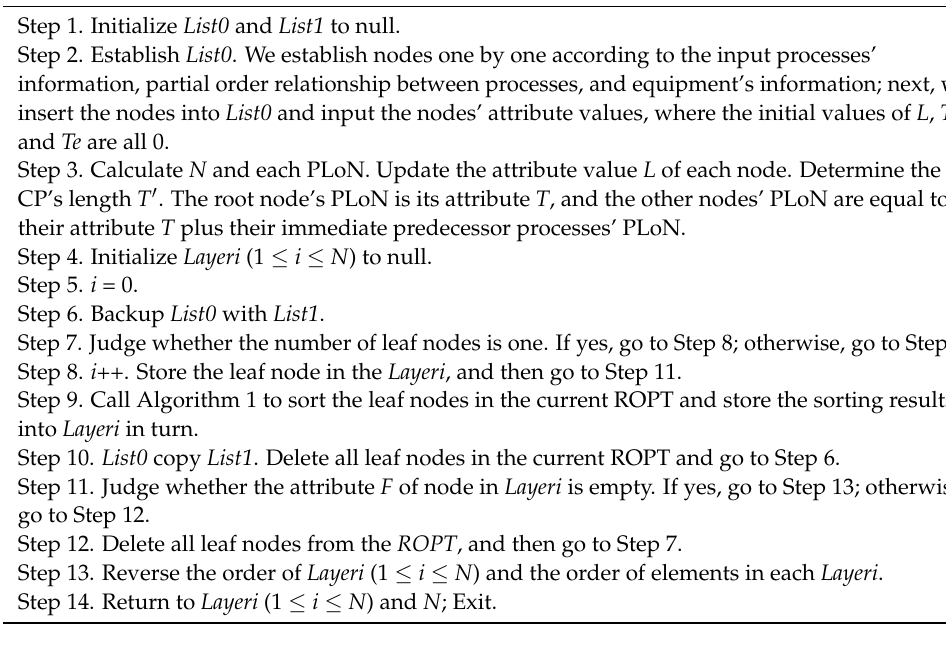
Algorithm 2 The steps of the process sorting